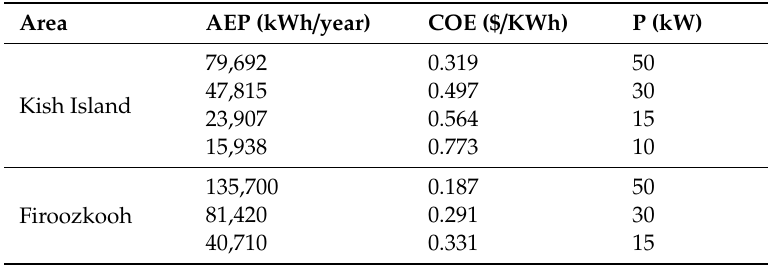
Table 6. The Pareto front result for a wind turbine without a